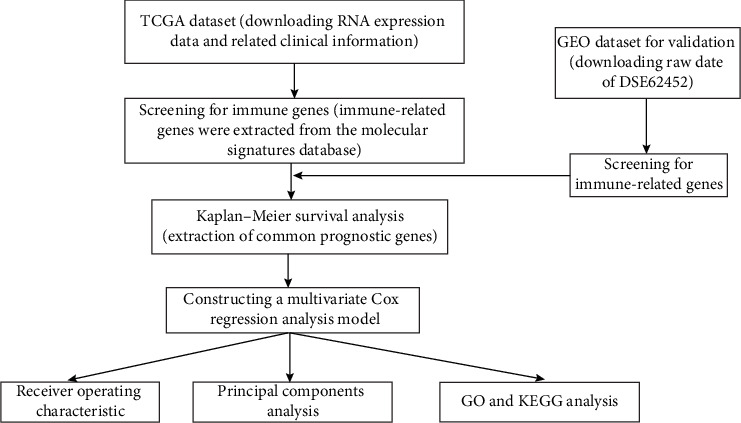
Flow chart of data preparation processing analysis and validation.